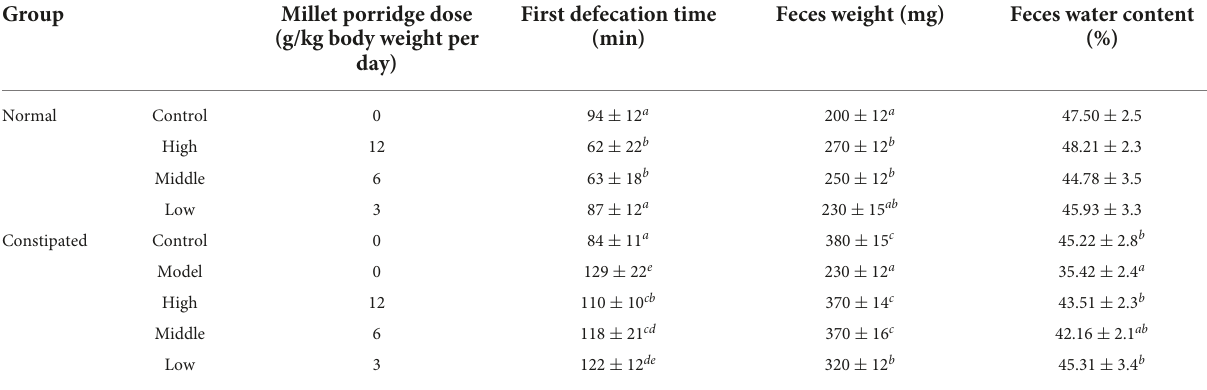
TABLE 2 Effects on the first defecation time, weight, and water content of feces in normal and constipated mice. Group